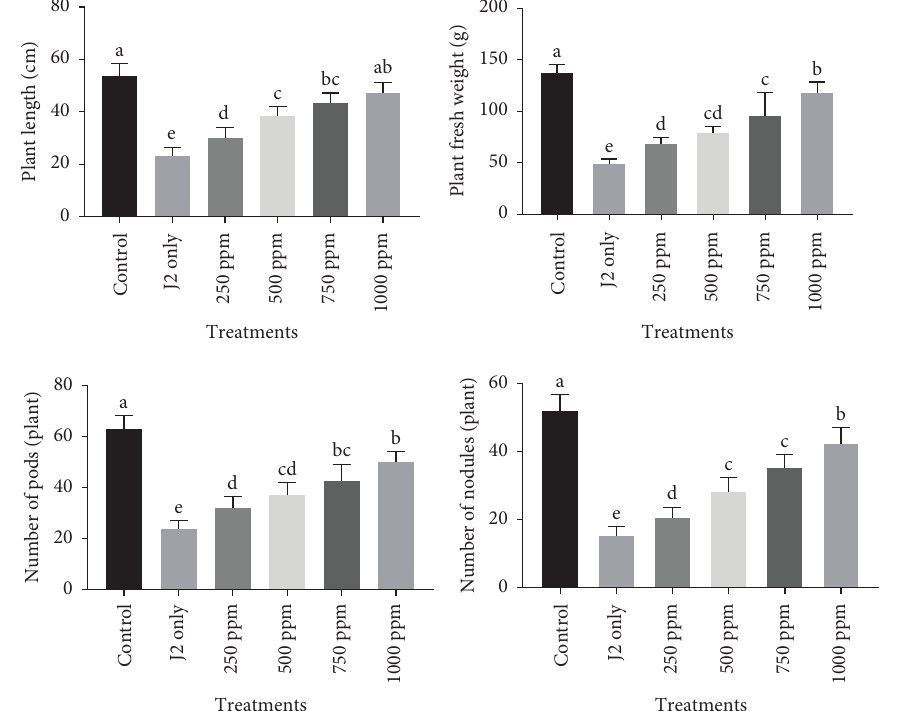
of J2s of M. incognita on chickpeas. Te reduced nematode